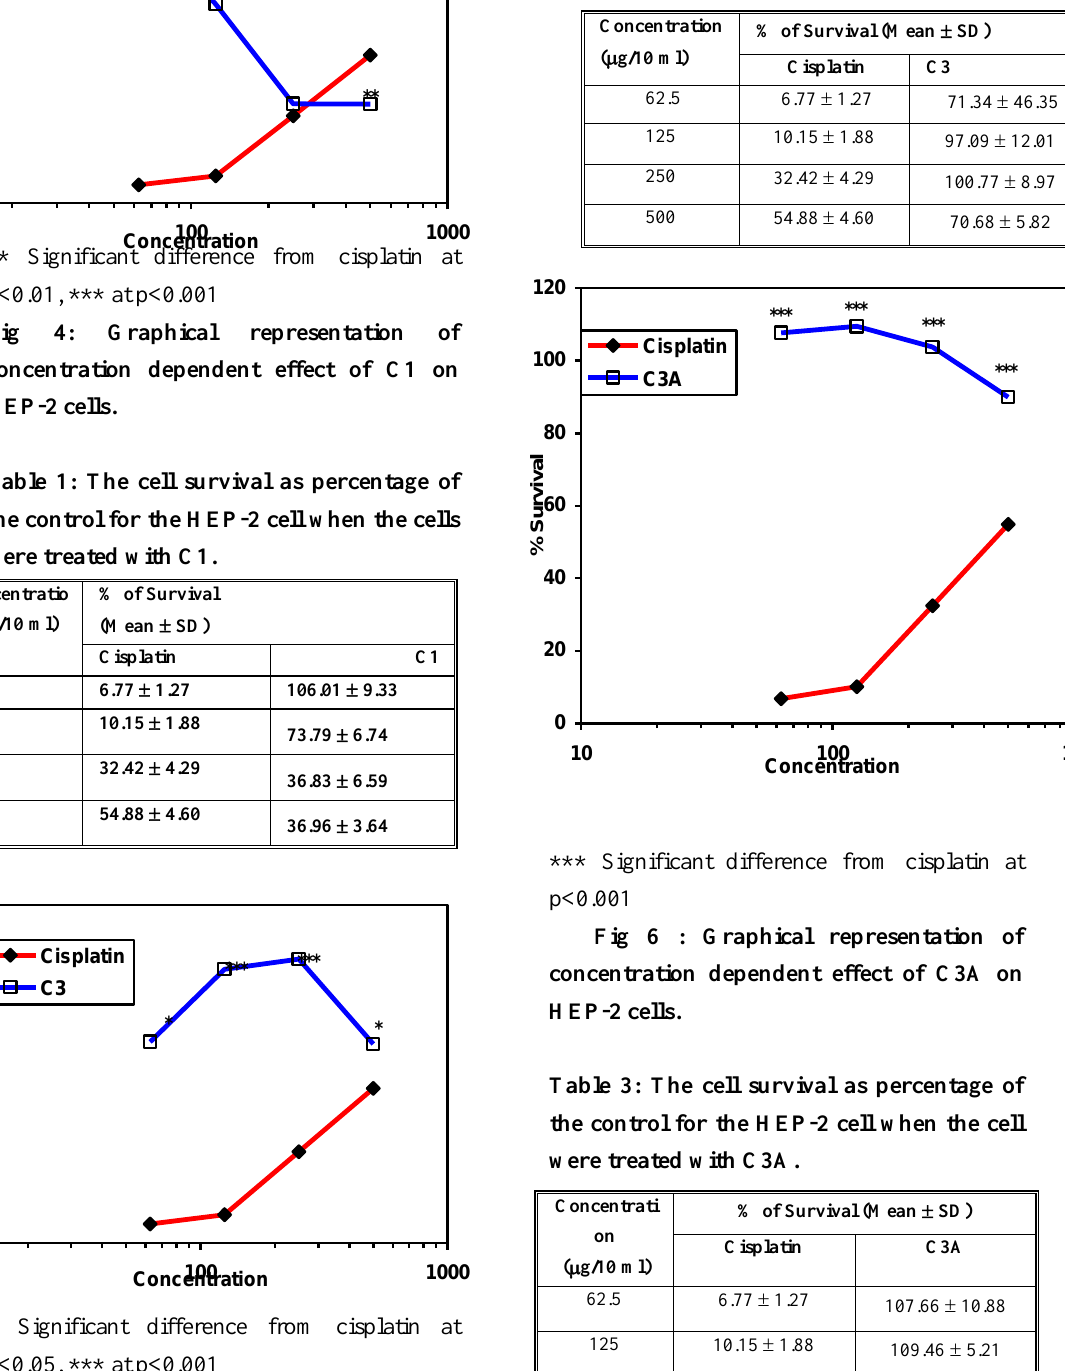
Fig 5: Graphical representation of concentration dependent effect of C3 on HEP-2 cells.